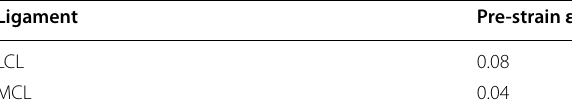
Table 1 Pre-strain of the collateral ligaments Ligament